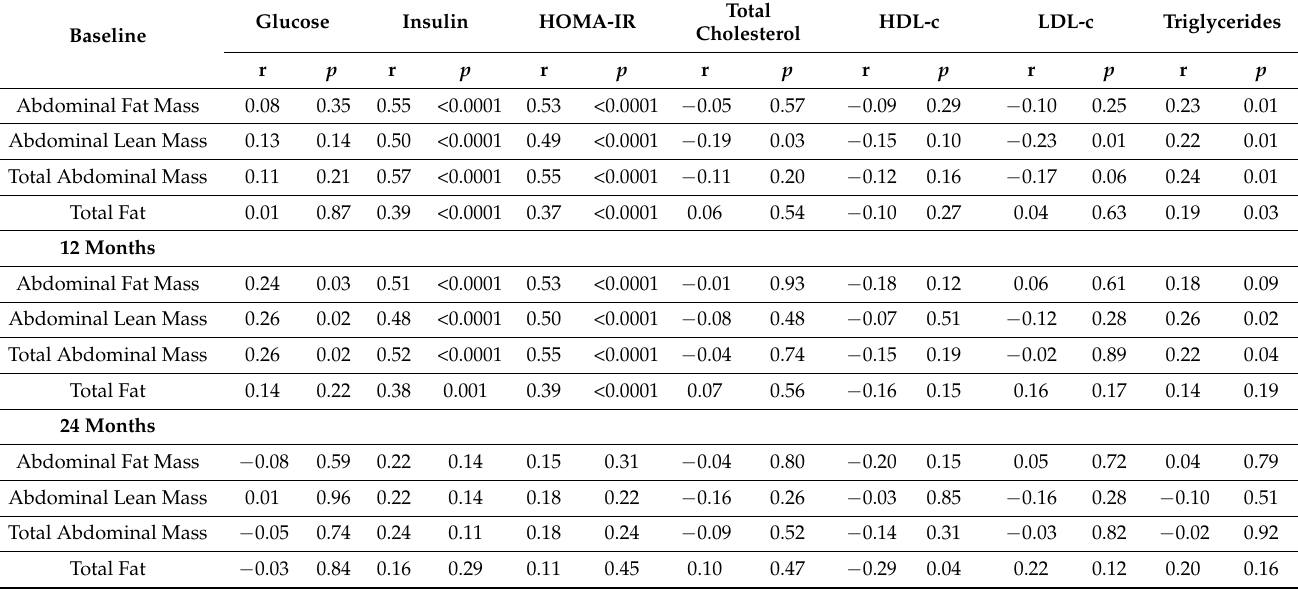
Table 6. Pearson correlation’s coefficient: body composition vs. metabolic parameters at baseline, and after 12 months and 24 months of